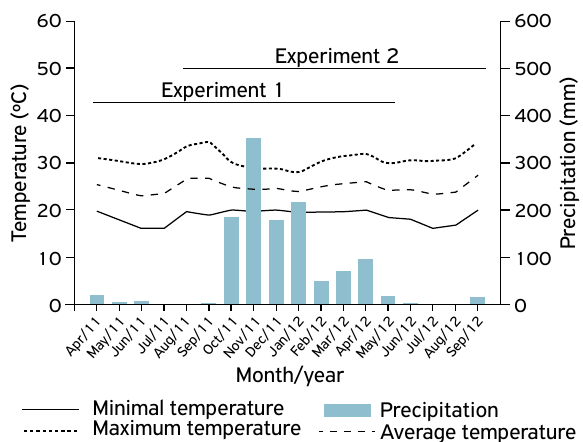
Figure 1. Minimal, average and maximum temperature (monthly average) and precipitation (accumulated month) during experimental period from April 2011 to September 2012. Goianésia, Goiás,